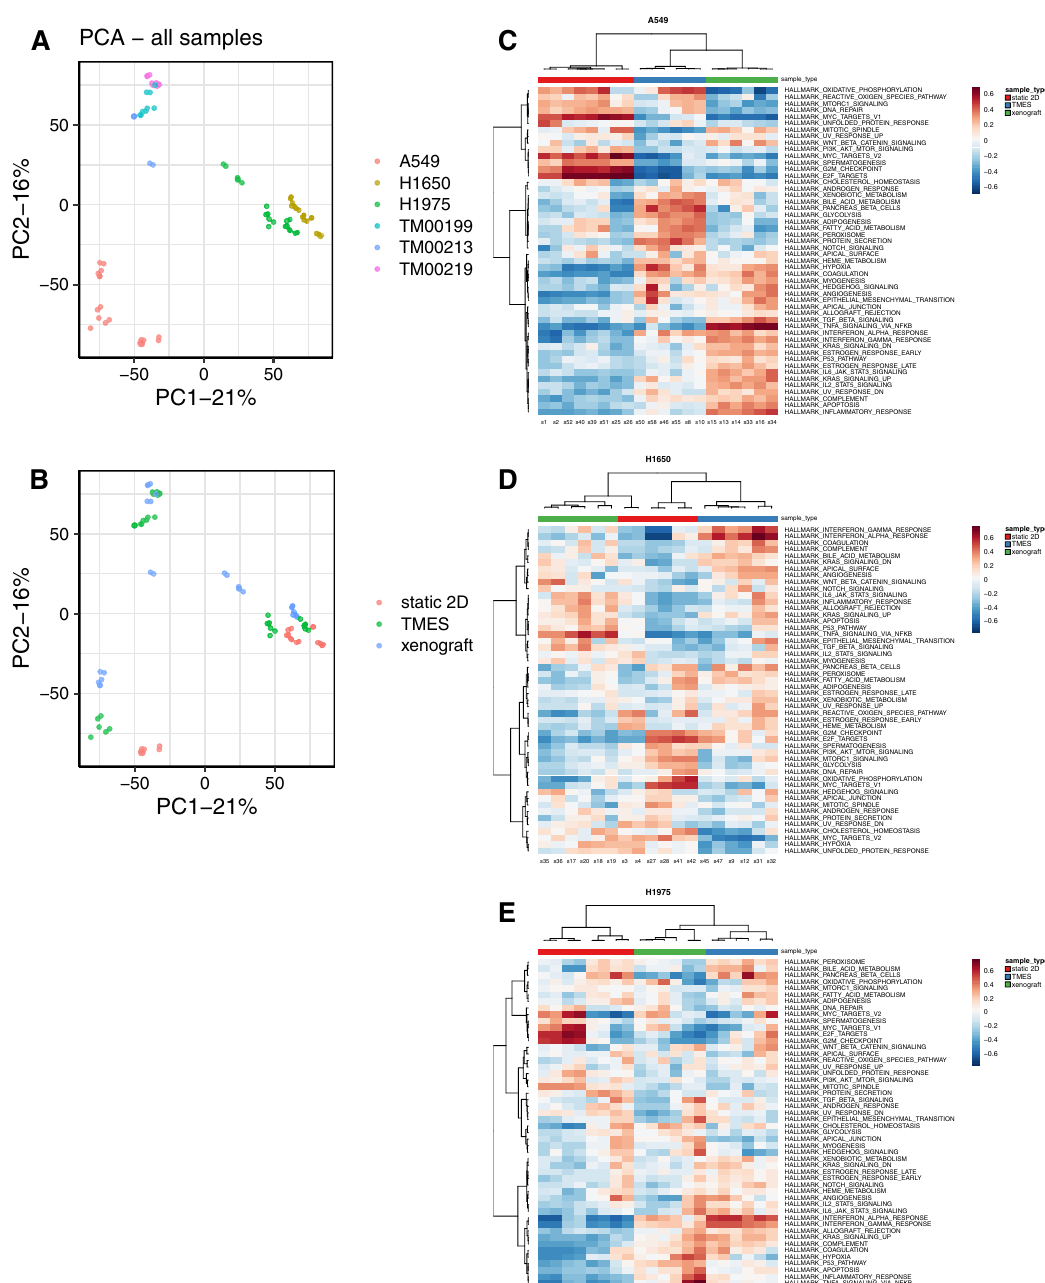
Figure 1. Transcriptomic Analysis of NSCLC in the model systems. Principal Component Analysis of RNAseq data from NSCLC tumor cell lines grown in the TMES, xenografts, and static 2D cultures and NSCLC PDX tumor cells grown in the TMES and PDXs. ( A ) PCA color coded by cell, ( B ) PCA color coded by growth condition. Heatmap of the Cancer Hallmark MSigDB gene set for ( C ) A549, ( D ) H1650, and ( E ) H1975 cells grown in the TMES, xenografts, and static 2D cultures. The heatmap color scales represents row-wise